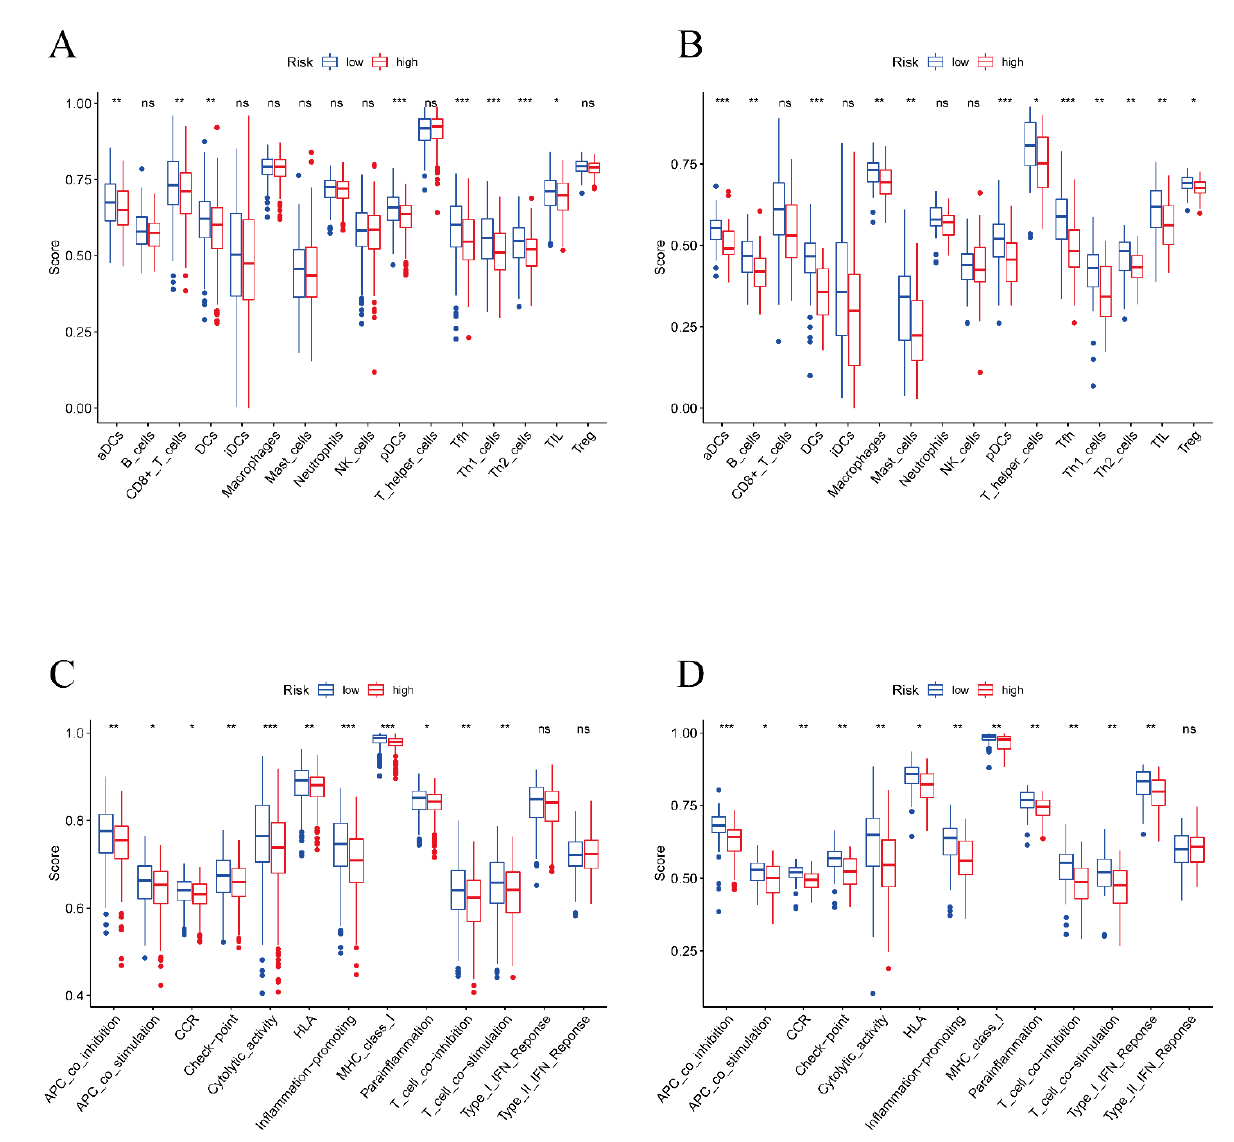
Figure 8. ssGSEA scores between different risk groups in the TCGA cohort and ICGC cohort. ( A ) The abundance of immune cells in the TCGA cohort. ( B ) The abundance of immune cells in the ICGC cohort. ( C ) The immune function analysis in the TCGA cohort. ( D ) The immune function analysis in the ICGC cohort. (* p < 0.05; ** p < 0.01, *** p < 0.001, ns: not